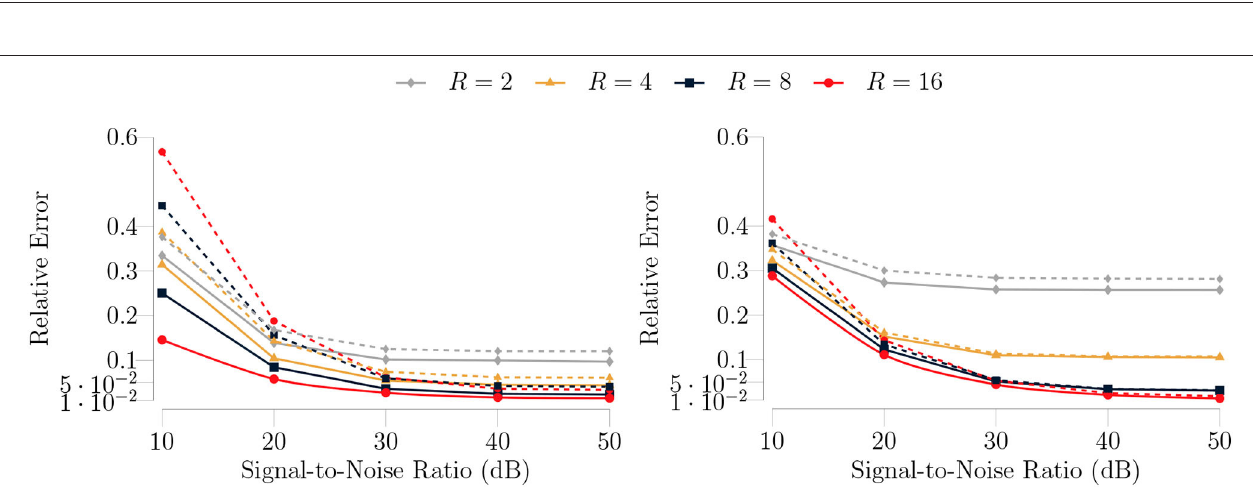
FIGURE 4 | (Left) The median test (dashed lines) and training (solid lines) errors of the type I model for 100 trials on the synthetic noisy data for a rank-8 function given as in Equation (29). The number of samples for the training dataset is set to 5,000 and for test dataset is set to 1,000. The batch size is set to 500 and the maximum number of GN iterations is set to 5. (Right) The median test (dashed lines) and training (solid lines) errors of the type II model with the same algorithm settings. TeMPO produces more accurate results and generalizes better for higher rank values for both the type I and type II model in the presence of noise as well. Again, the type I model produces better results for low rank values, i.e., R < R f , because it involves more parameters than the type II